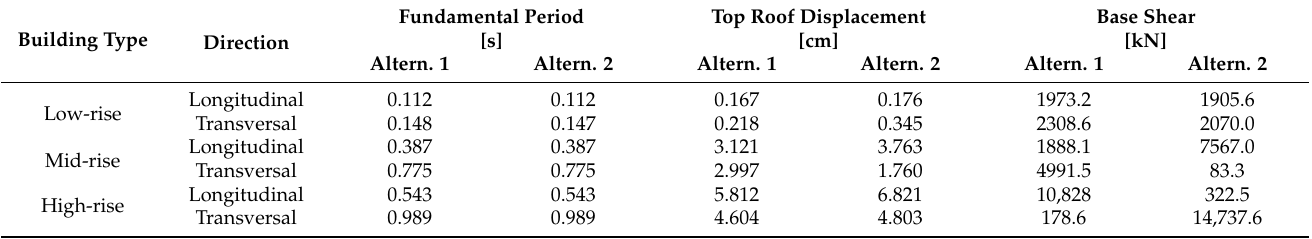
Table 9 . Responses of the three investigated buildings for the two alternatives of VDs placement.